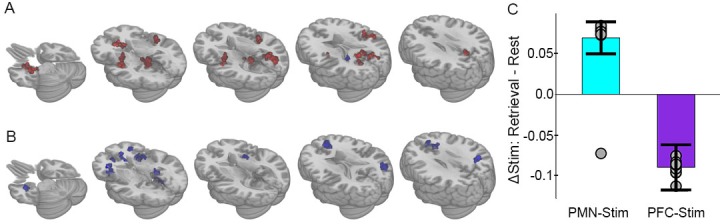
Selective effects of PMN-targeted stimulation on memory-related connectivity.(A) Regions showing significant interaction between stimulation condition and cognitive task following PMN-targeted stimulation, with red coloration indicating stimulation increased connectivity more during retrieval than during rest and blue coloration indicating the opposite effect. Comprehensive view shown in Figure Supplements. (B) Regions showing significant interaction between stimulation condition and cognitive task following PFC-targeted control stimulation. (C) Mean stimulation effect on connectivity during memory retrieval relative to rest for all supra-threshold regions. Error bars are provided for illustrative purposes and indicate subject-level standard error of the mean for all supra-threshold regions. Points indicate the mean effect for each supra-threshold region. Note: Statistical values are not indicated, as this would be redundant with the statistical definition of these supra-threshold regions.10.7554/eLife.49458.014Figure 4—source data 1.Whole-brain analysis, PMN-targeted group.Subject: 1–16 = PMN targeted group, 17–32 = PFC targeted group. State: Autobiographical memory task (Retrieval) or resting-state (Rest). Condition: Full stimulation (Stim) or sham stimulation (Sham). Cluster: Significant cluster identified via whole-brain analysis. Memory: Percent of memory trials with correct context recollection. Connectivity: Average global correlation within the cluster for that scan. tSNR: Average whole-brain temporal signal to noise ratio for that scan.10.7554/eLife.49458.015Figure 4—source data 2.Whole-brain analysis, PFC-targeted group.Subject: 1-16=PMN-targeted group, 17-32=PFC-targeted group. State: Autobiographical memory task (Retrieval) or resting-state (Rest). Condition: Full stimulation (Stim) or sham stimulation (Sham). Cluster: Significant cluster identified via whole-brain analysis. Memory: Percent of memory trials with correct context recollection. Connectivity: Average global correlation within the cluster for that scan. tSNR: Average whole-brain temporal signal to noise ratio for that scan.